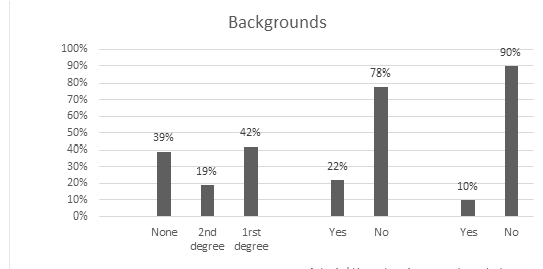
Figure 3. Distribution of backgrounds in